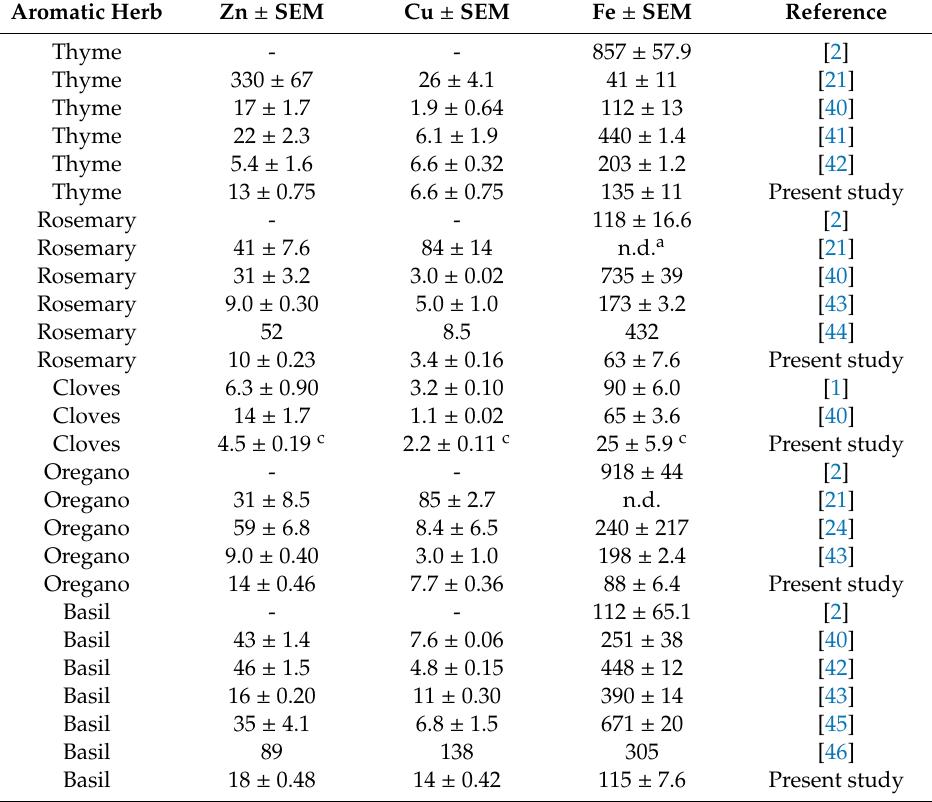
Table 1. Mean Zn, Cu, and Fe concentrations ( µ g / g) and standard error of the mean (SEM) in commercial samples of dehydrated herbs (thyme, rosemary, cloves, oregano, and basil) measured in the present study in comparison to those determined by other researchers.